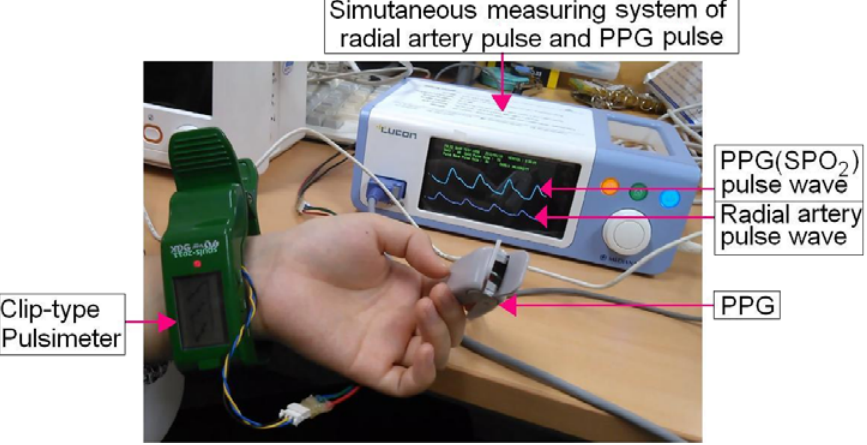
Figure 4. Radial artery pulse and PPG waves obtained from the simultaneous measurements by the clip-type pulsimeter and the PPG meter mounted on the wrist and fingertip, respectively, of the subject’s left.